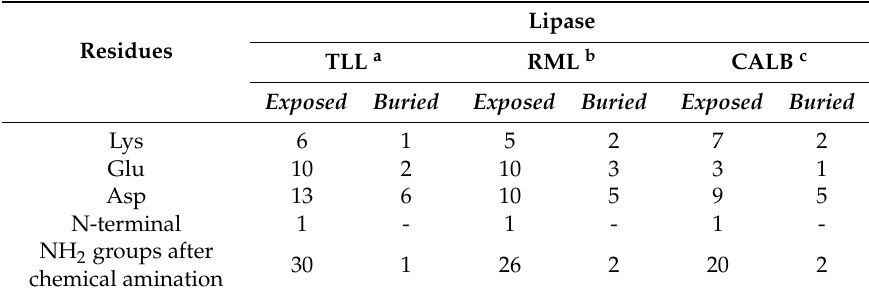
Table 1. Number of Lys, Glu, and Asp residues on TLL, CALB, and RML. Lipase Residues TLL a RML b CALB c Exposed Buried Exposed Buried Exposed